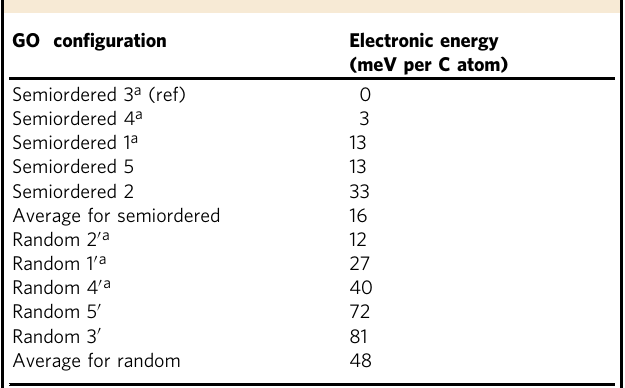
Table 1 Relative total energy E − E ref (in meV per carbon atom) of the ten generated semiordered or random GO structures with respect to the most stable system, labeled “ ref ” .